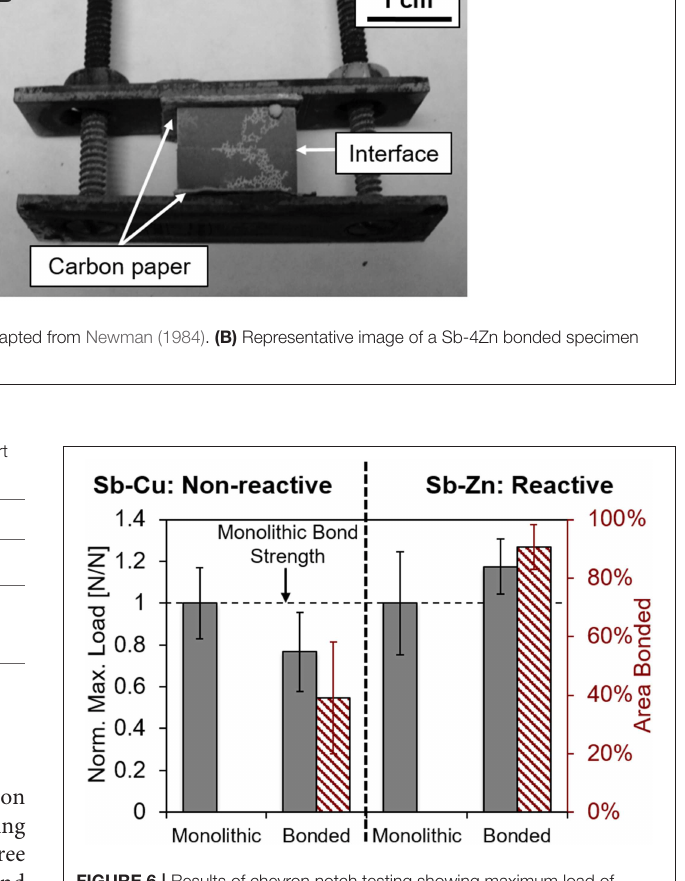
FIGURE 6 | Results of chevron notch testing showing maximum load of bonded Sb-Cu and Sb-Zn normalized to their respective monolithic maximum